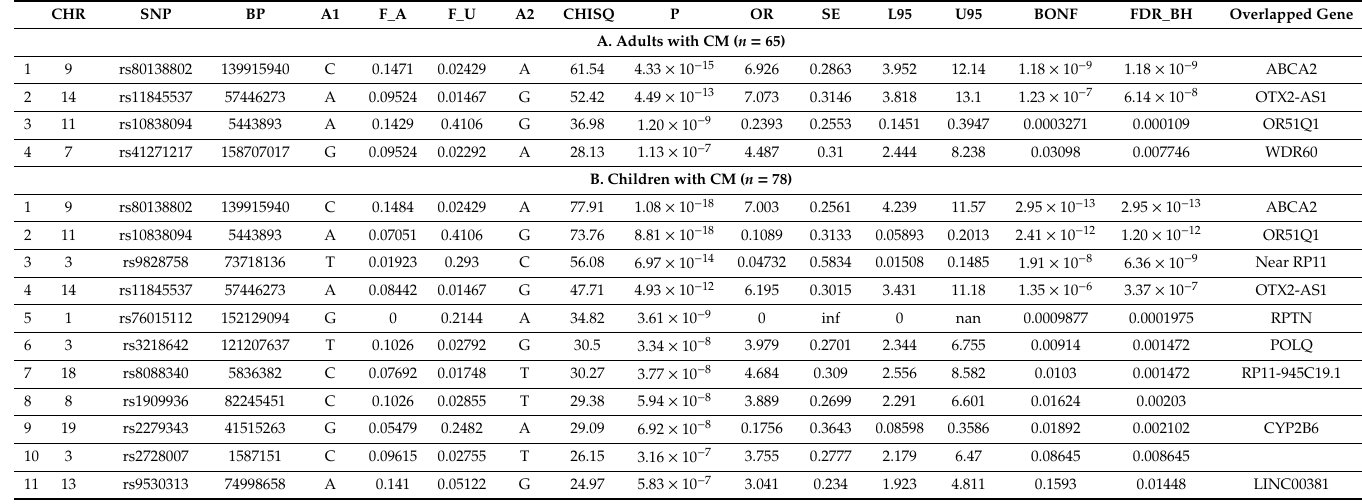
Table legend: CHR—chromosome, BP—base pair based on the human reference genome GRCh37, A1—minor allele, A2—major allele, F_A—frequency of A1 allele in patients, F_U—frequency of A1 allele in controls, CHISQ—basic allelic test chi-square (1df), P— p -value for CHISQ, OR—odds ratio, SE—standard error, L95 and U95—95% confidence interval for odds ratio, lower bound and upper bound, respectively, BONF—Bonferroni single-step adjusted p -values, FDR_BH—Benjamini & Hochberg (1995) step-up false discovery rate